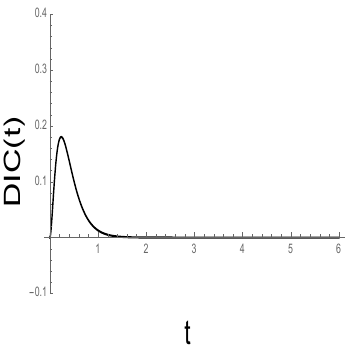
Figure 5. The DIC ( t ) estimated from a parallel exhaustive system that satisfies weak marginal selectivity with A L = 3, A H = 12, B L = 1, B H = 4.